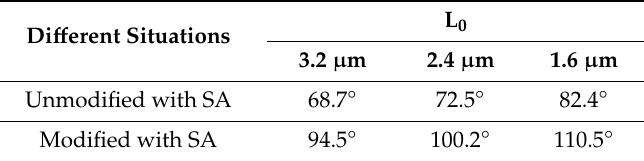
Table 1. Water contact angles of different copper sheets.